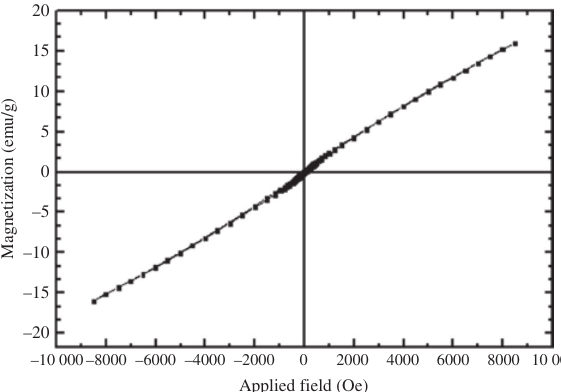
O -TiO nanocomposites 12 19 2